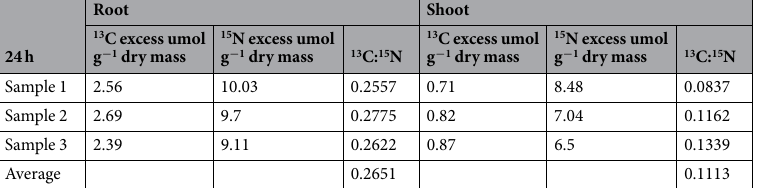
Table 1. 13 C excess, 15 N excess, and 13 C: 15 N ratio in shoot and root of Pakchoi 24 h after γ -PGA